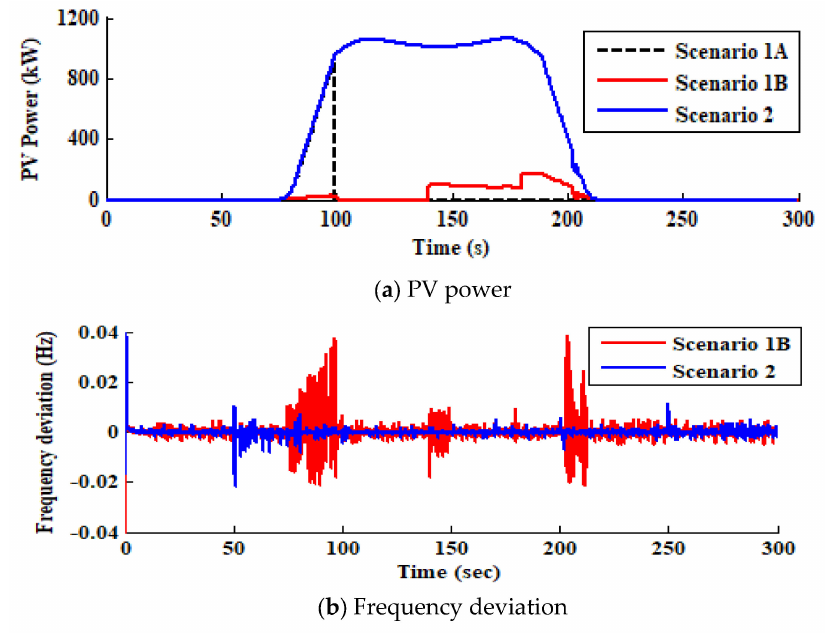
Figure 12. The simulation results for the comparative